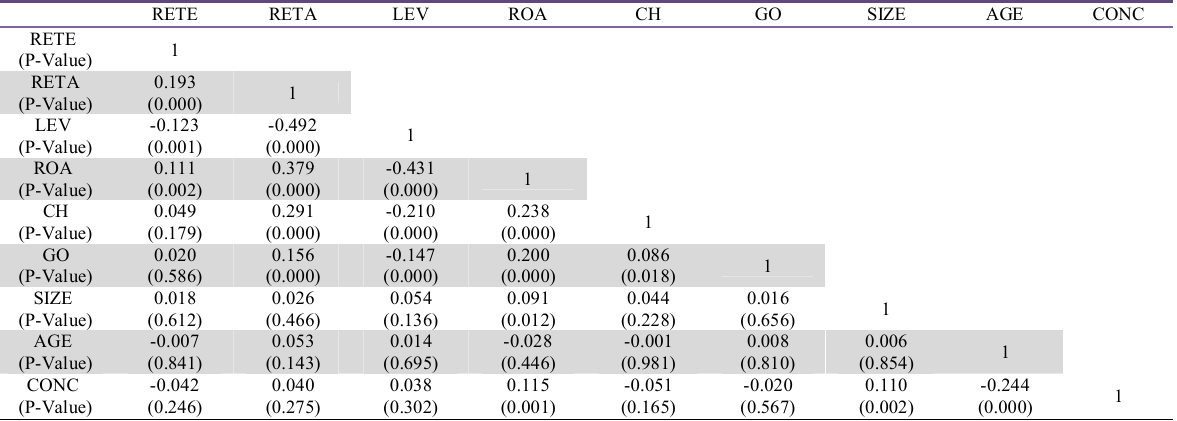
The summary of correlation among independent